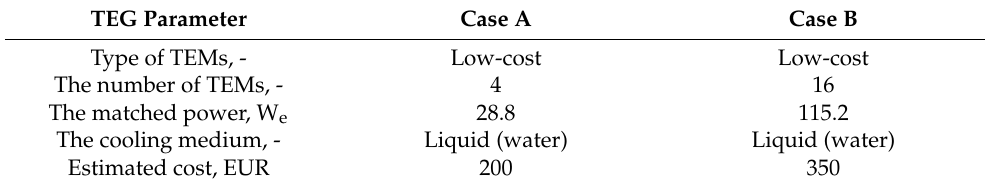
Table 2. The essential parameters of thermoelectric generators assumed by economic analysis. TEG Parameter Case A Case B Type of TEMs, - Low-cost Low-cost The number of TEMs, - 4 16 The matched power, W e 28.8 115.2 The cooling medium, - Liquid (water) Liquid (water) Estimated cost, EUR 200